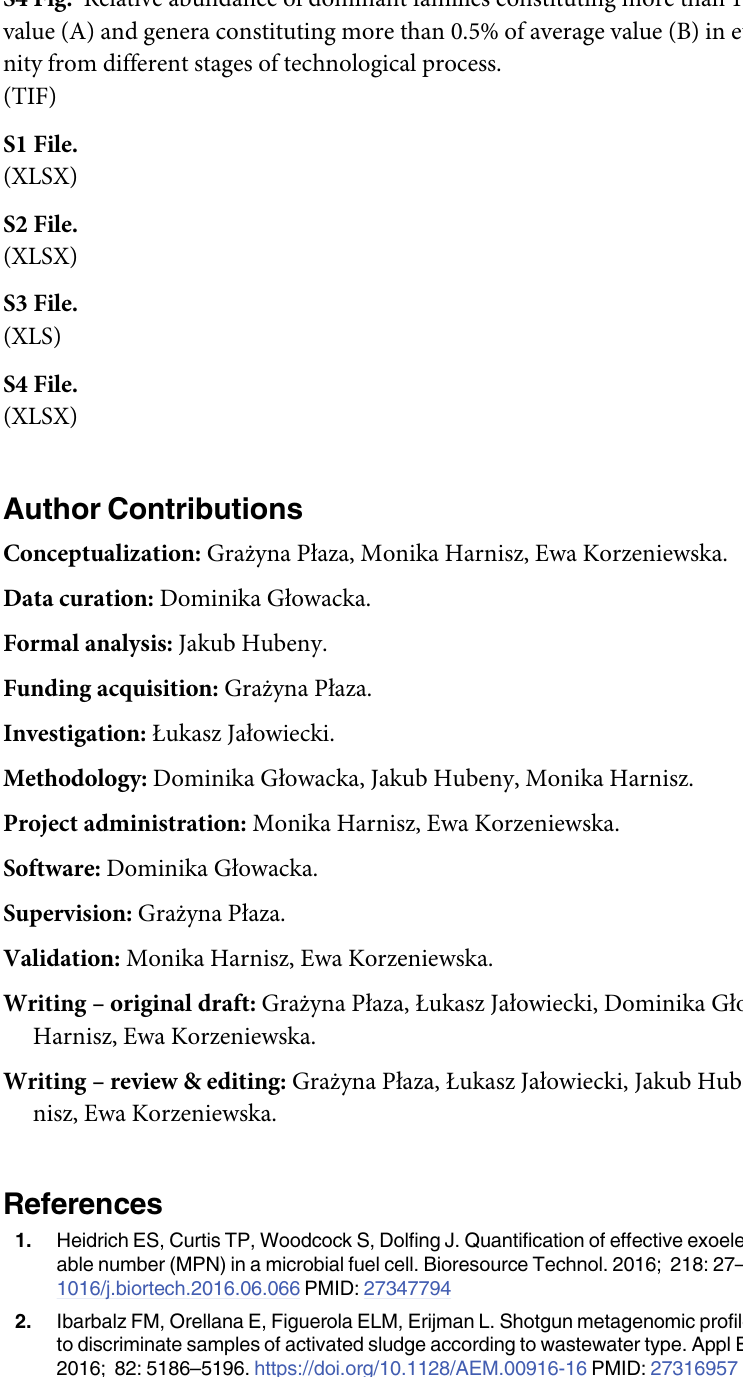
(TIF) S3 Fig. Relative eubacterial community abundance at phyla (A), class (B), and order (C) levels in the samples from different stages of technological process. (TIF) S4 Fig. Relative abundance of dominant families constituting more than 1% of the average value (A) and genera constituting more than 0.5% of average value (B) in eubacterial commu- nity from different stages of technological